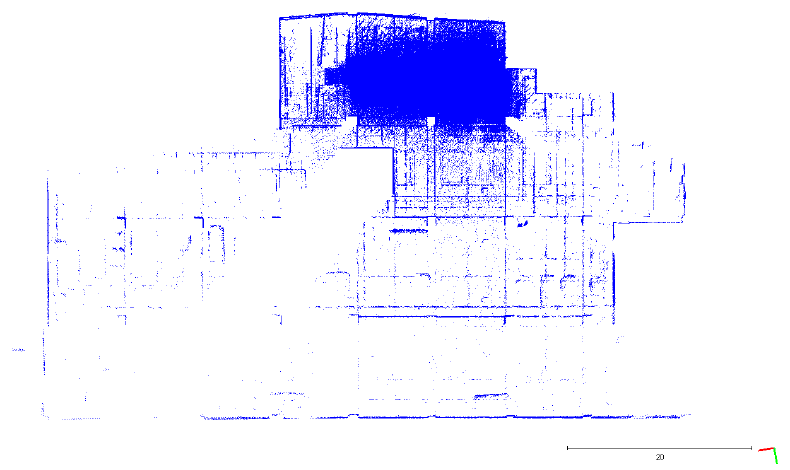
Figure 14. Handheld LiDAR point cloud after point cloud filtering for dataset DATA3. The handheld LiDAR point cloud corresponding to each plane (see Figure 4) was selected manually, and the point number contained on each plane and the ranging